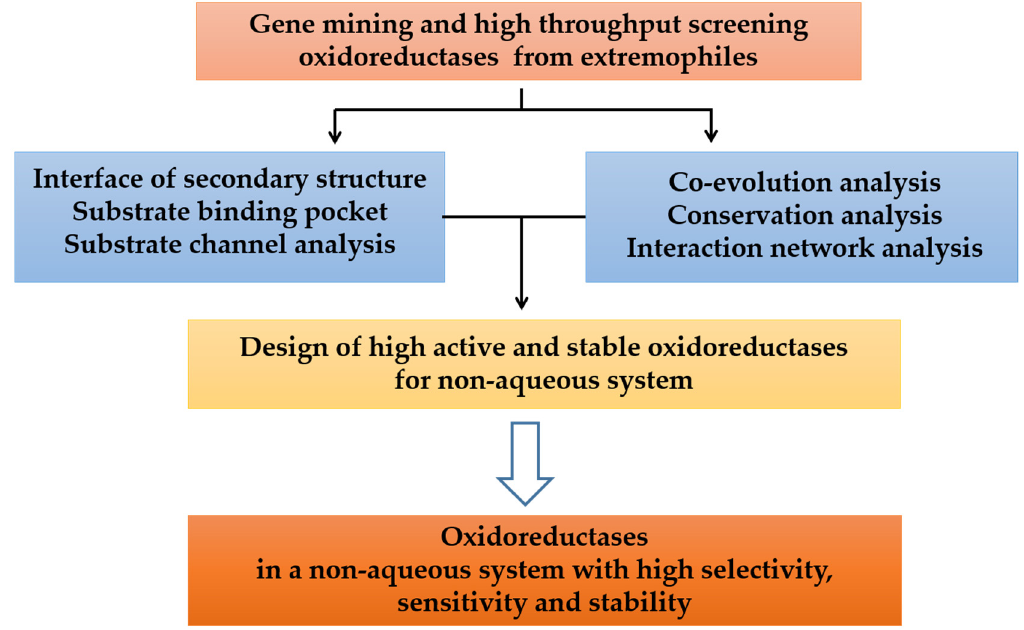
Figure 1. Exploring and designing oxidoreductases from extremophiles for biocatalysis in a non- aqueous system.